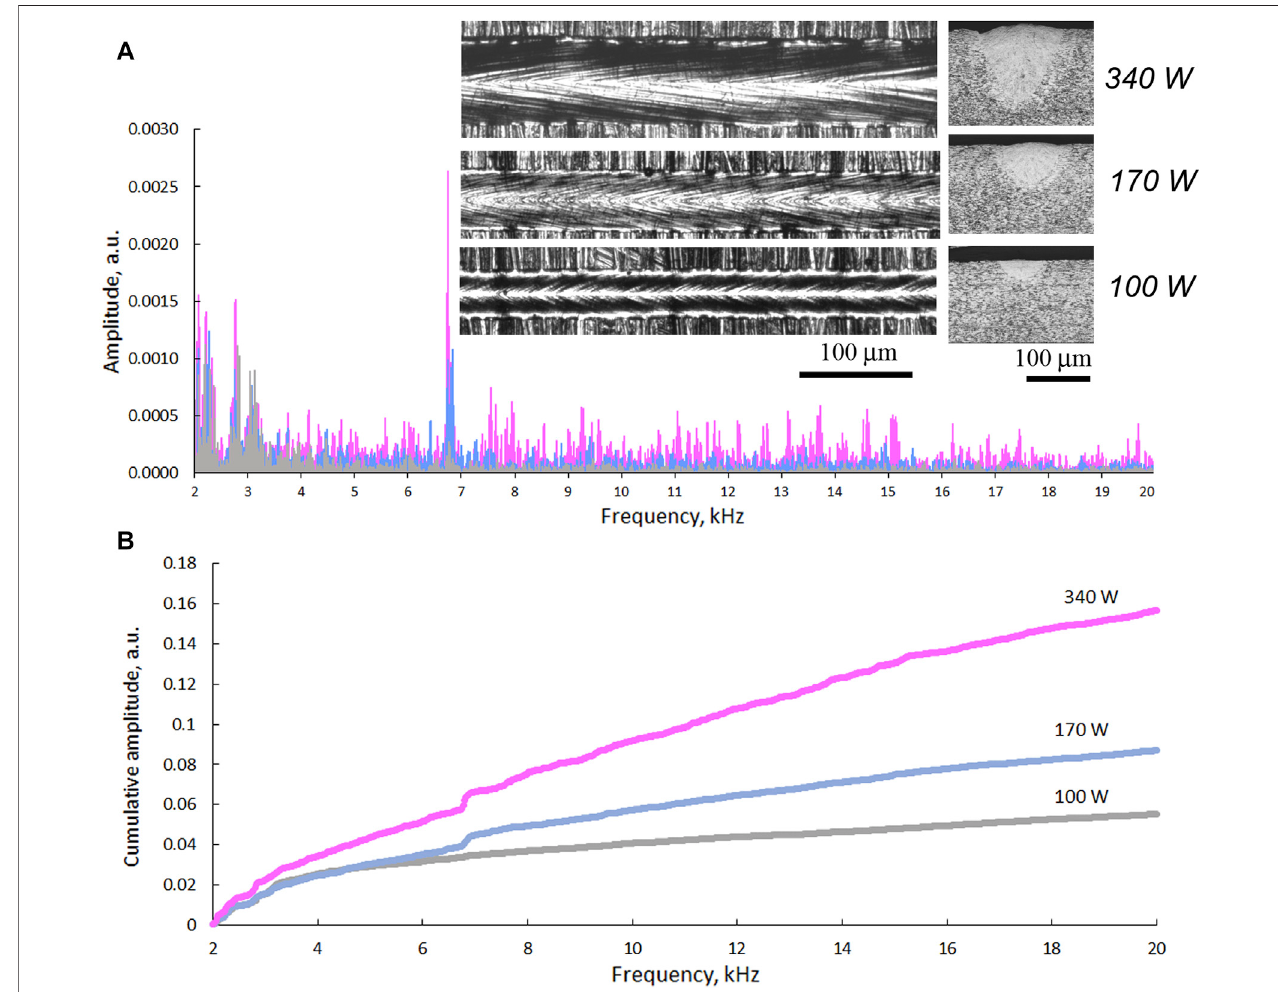
FIGURE 7 | Typical FFT spectrum and photos of single tracks without powder at 100, 170, and 340 W laser powers and 1.2 m/s scanning speed (A) and cumulative amplitude at 2 – 20 kHz (B) .